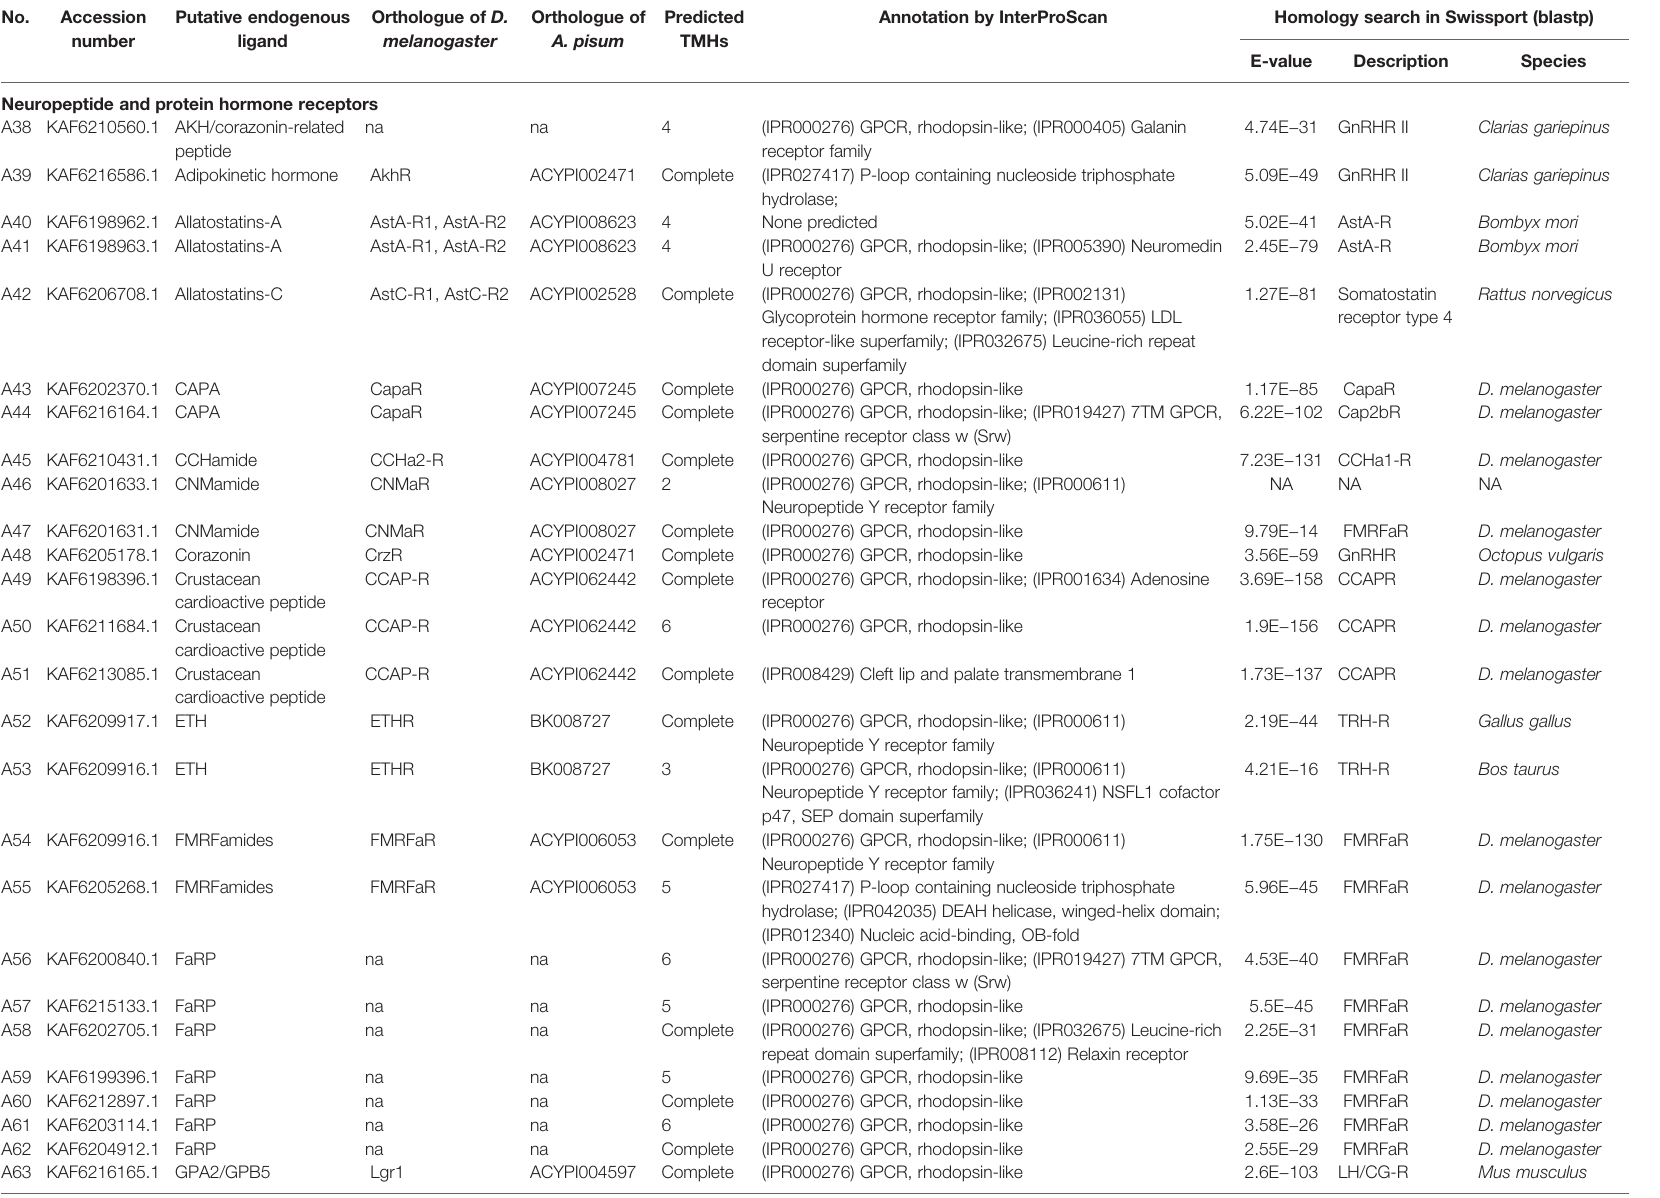
TABLE 2 | Neuropeptide and protein hormone receptors and purine GPCRs in A. lucorum